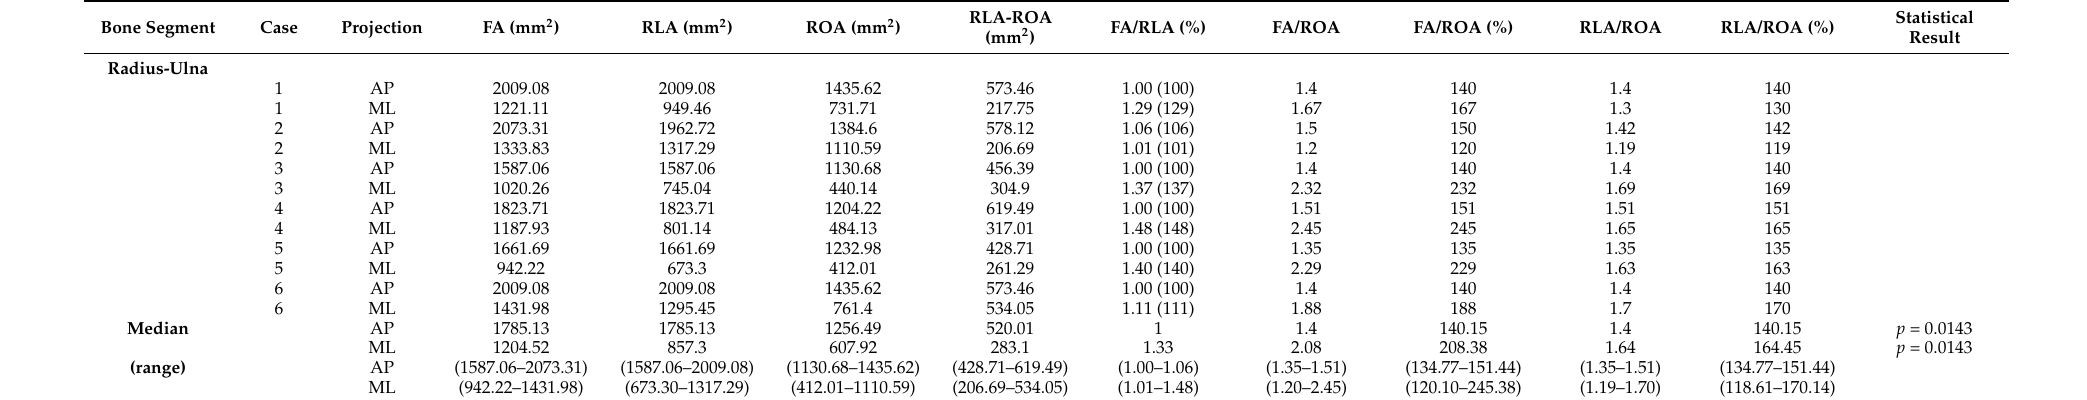
Table 2. Measurements of the radius-ulna in the antero-posterior (AP) and medio-lateral (ML) view.